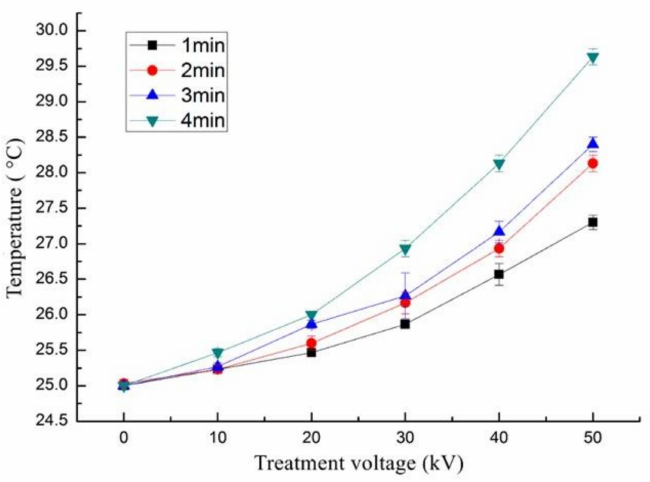
Figure 4. Effect of different ACP treatment voltage and time on the temperature of trypsin (mean ± SD, n = 3). Control (0 min) refers to samples without ACP treatment.